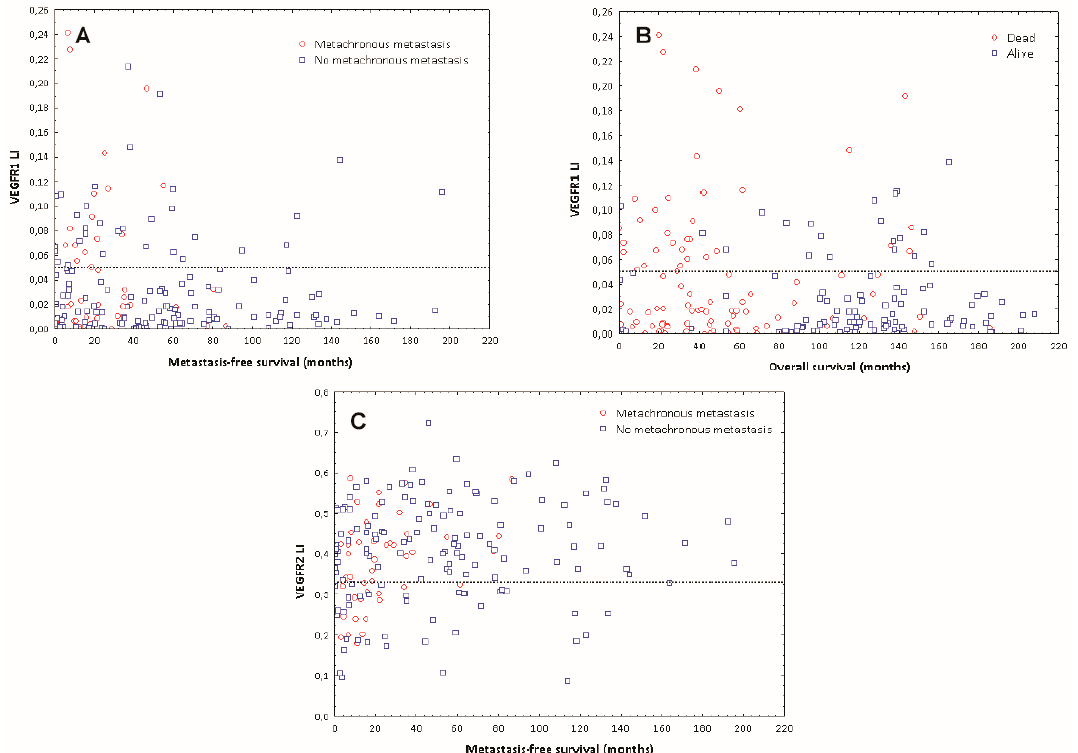
Figure 3. Distribution of VEGFR ‐ 1 and VEGFR ‐ 2 expression in ECs relative to survival: ( A ) LI values ≤ 5% for VEGFR ‐ 1 expression in CRC ECs identify the majority of patients with a low metastasis risk. Red/blue dots identify metastatic/metastasis ‐ free patients, respectively. ( B ) LI values ≤ 5% for VEGFR ‐ 1 expression in CRC ECs identify the majority of patients with improved overall survival. Red/blue dots identify dead/alive patients respectively. ( C ) LI values ≥ 33% for VEGFR ‐ 2 expression in CRC ECs identify the majority of patients with a low metastasis risk. Red/blue dots identify metastatic/metastasis ‐ free patients respectively.